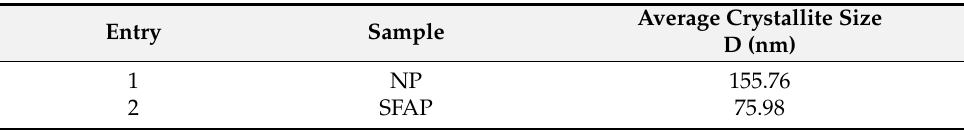
Figure 2. XRD patterns of: ( a ) NP; the blue triangle is showing the diffraction peak of coesite, SiO 2 (JCPDS 72-1601) [48], and ( b ) SFAP. (Red numbers represent the crystalline planes). Table 1. Average crystallite size of the